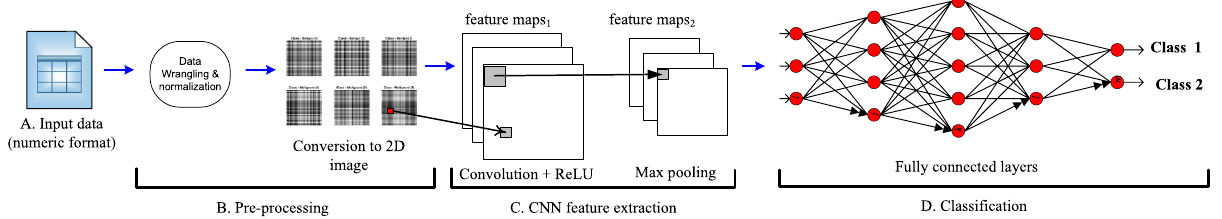
Figure 3. A complete process of non-image tabular data classification with CNN.